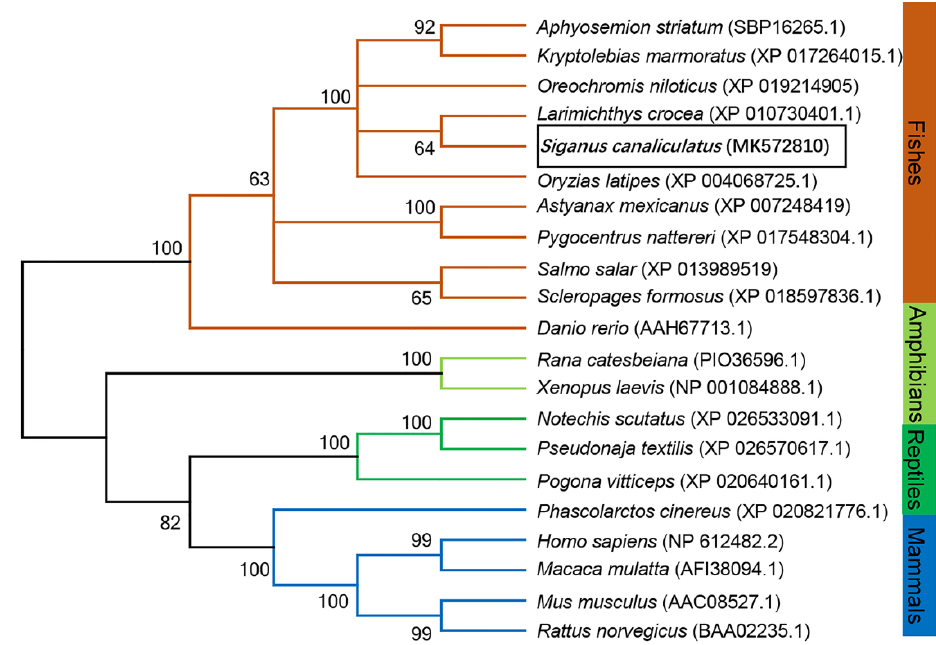
Figure 2. Phylogenetic analysis of the deduced amino acid sequences of Sp1 proteins from rabbitfish and other species with the neighbor-joining method by using MEGA 5.0 Version. Bootstrap values were obtained from 1000 repetitions and illustrated as percentages at the nodes. The sequences of rabbitfish Sp1 are boxed.